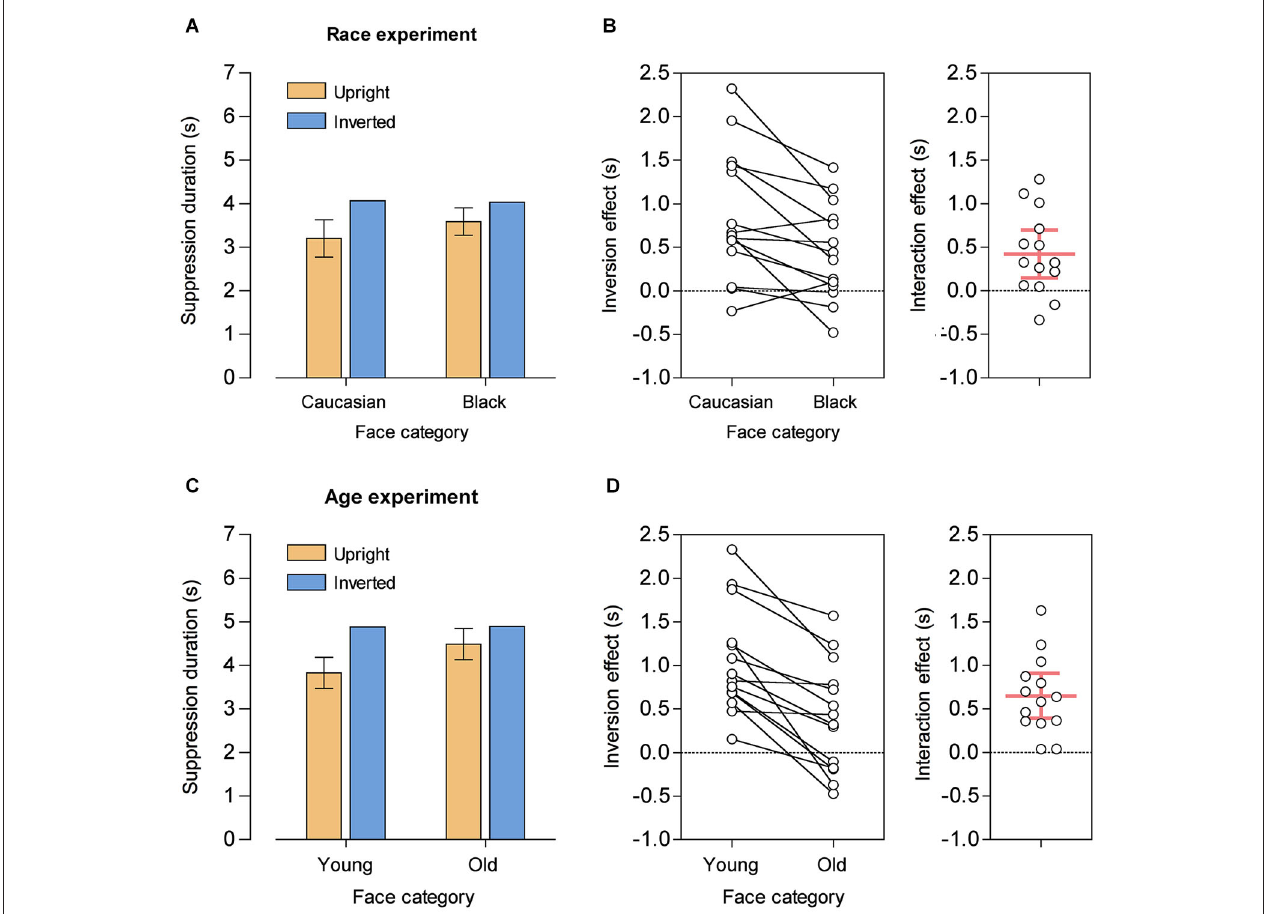
faces. The red horizontal bar denotes the group mean and the red vertical error bar represents the 95% CI. (C) Mean suppression durations for upright and inverted young and old faces. Error bars show 95% CIs for the mean difference between upright and inverted faces, separately for young and old faces. (D) Individual subject data. Left panel: Inversion effects for young and old faces. Right panel: Interaction effect, with positive values reflecting a larger inversion effect for young faces than for old faces. The red horizontal bar denotes the group mean and the red vertical error bar represents the 95%